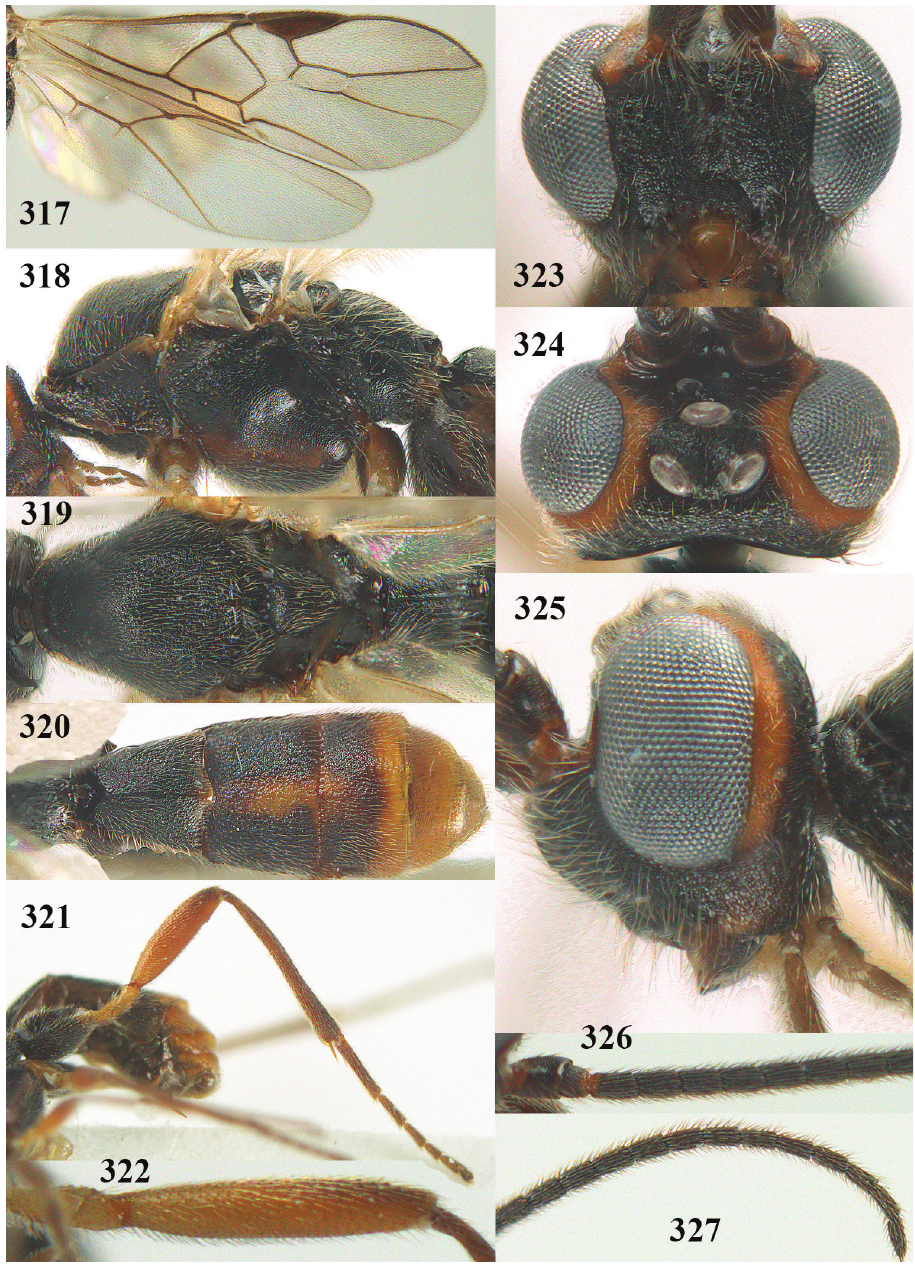
Figures 317–327. Aleiodes ryrholmi sp. n., ♀ , holotype. 317 wings 318 mesosoma lateral 319 meso- soma dorsal 320 propodeum and metasoma dorsal 321 hind leg lateral 322 fore femur lateral 323 head anterior 324 head dorsal 325 head lateral 326 basal segments of antenna 327 apical segments of